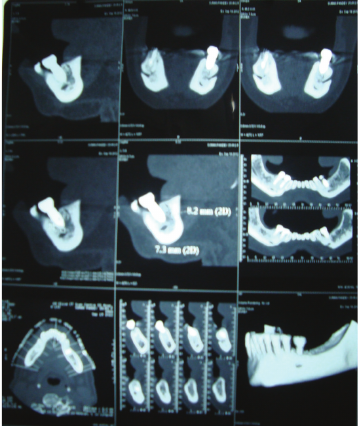
Figure 6: Dentascan 12 months after prosthetic rehabilitation.